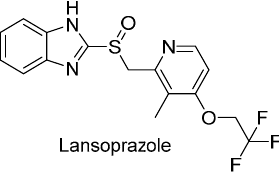
Figure 15. The chemical structure of lansoprazole.